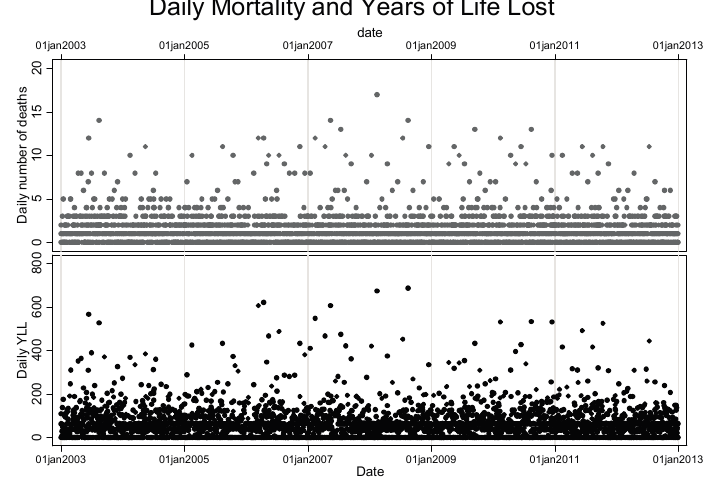
Figure 1. Distribution of deaths and YLL the over study